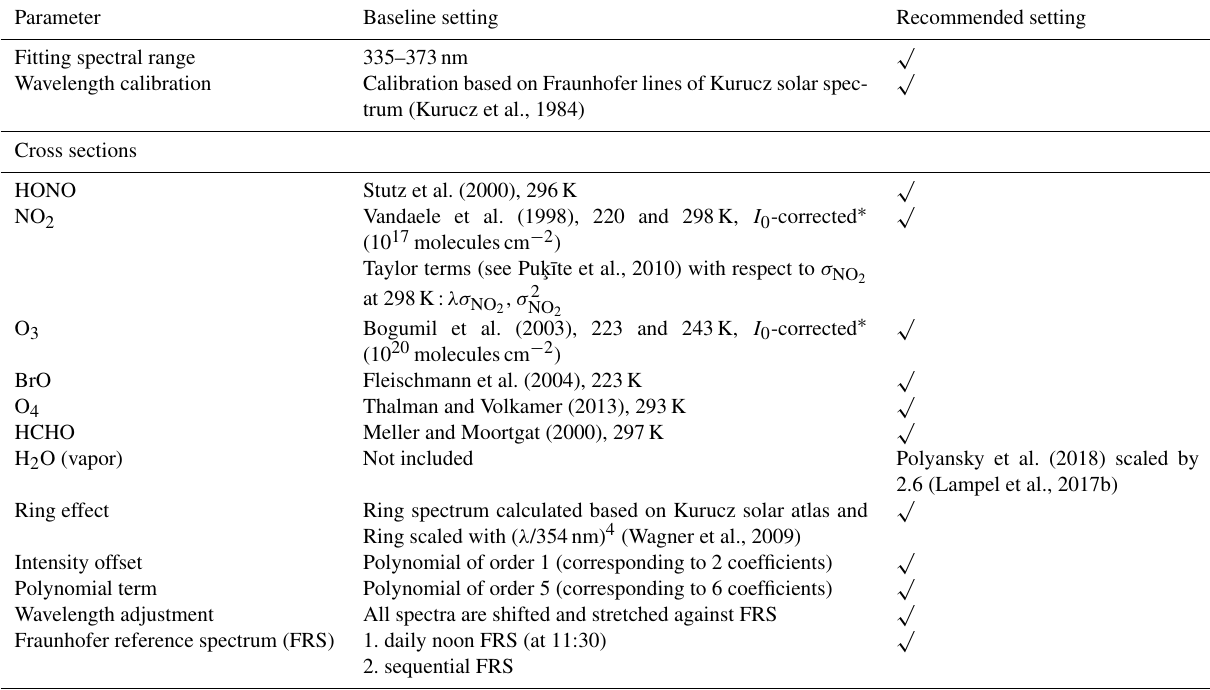
Table 2. Baseline DOAS analysis settings of HONO delta SCDs and dSCDs for the comparison activity and recommended settings. indicates the item for recommended setting is same as that for baseline